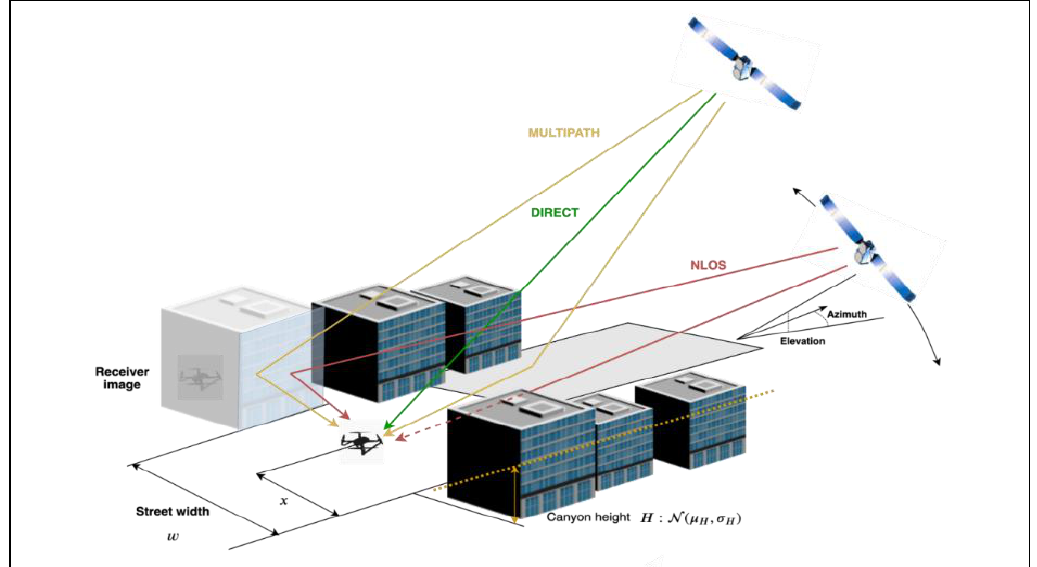
Figure 5. Satellite visibility and NLOS / multipath conditions in a typical urban